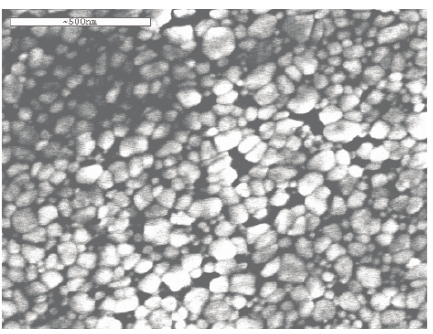
Figure 3: SEM surface micrograph of the samples after EF&H treatment at 6000 V/cm and 500 ∘ C for 1h.